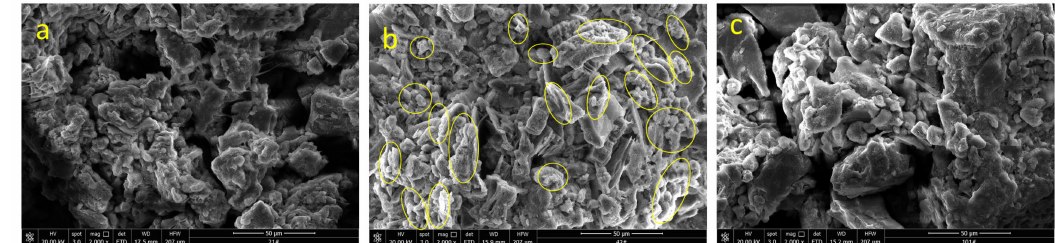
Figure 7. SEM images of the center part of samples during the (NH 4 ) 2 SO 4 solution leaching process. ( a – c ): SEM images of the middle part of the samples with a leaching time of 0.5 h ( a ), 1 h ( b ) and 2 h ( c